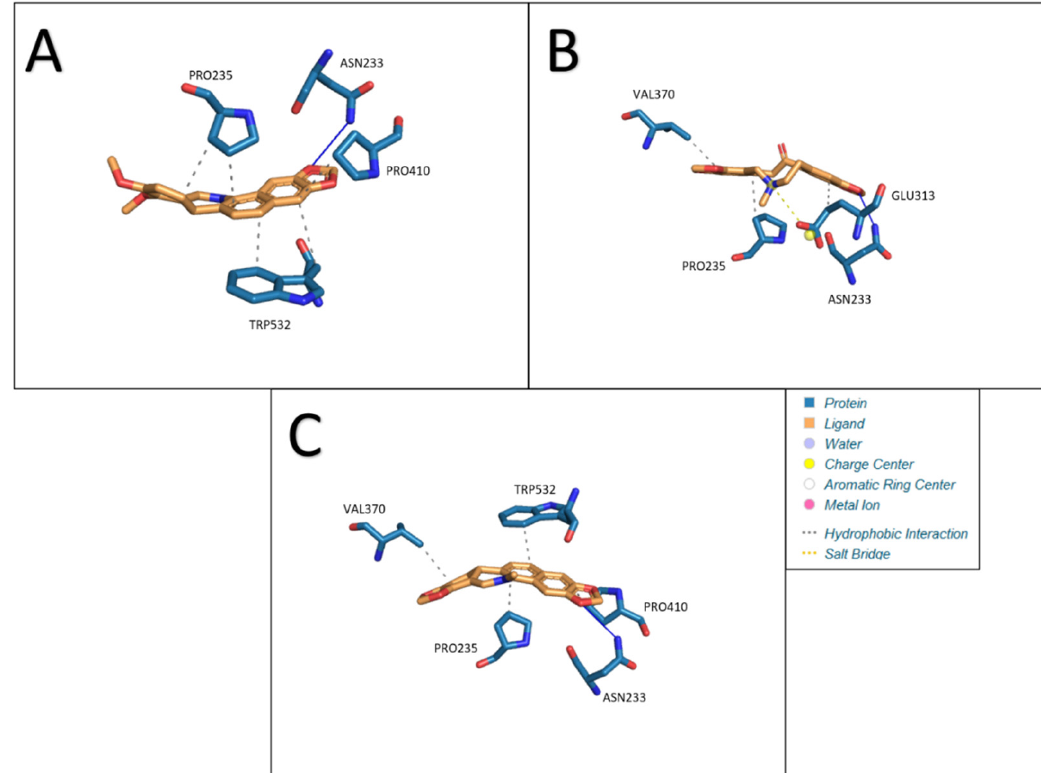
Figure 7. Interactions between AChE and ligands: ( A ) chelerythrine, ( B ) protopine, ( C ) sanguinarine. Table 7. AChE and BChE: free energy of binding, inhibition constant, and bonds